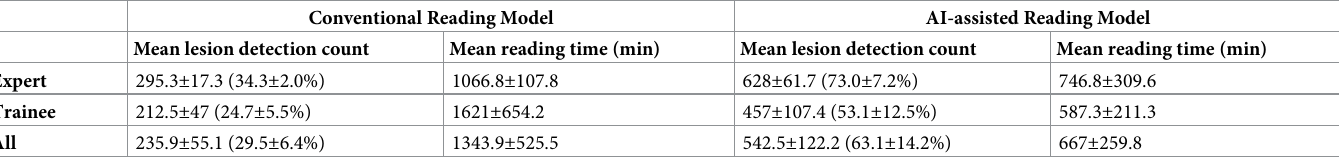
Table 4. Comparison of the lesion detection rates and reading times of reviewer groups between the reading